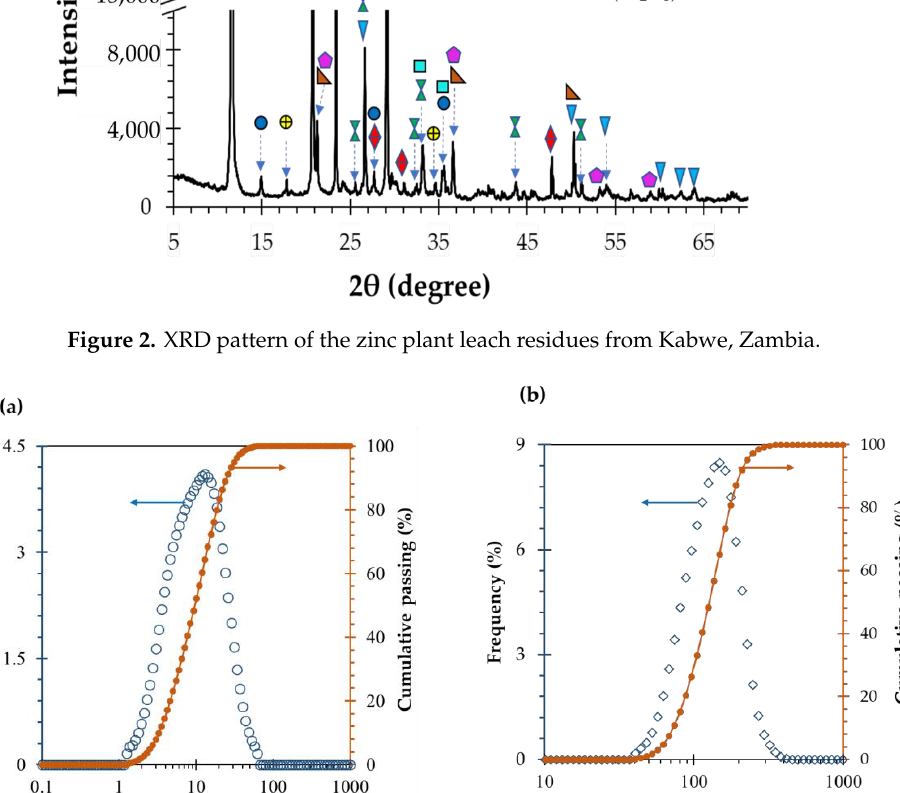
Figure 2. XRD pattern of the zinc plant leach residues from Kabwe, Zambia.